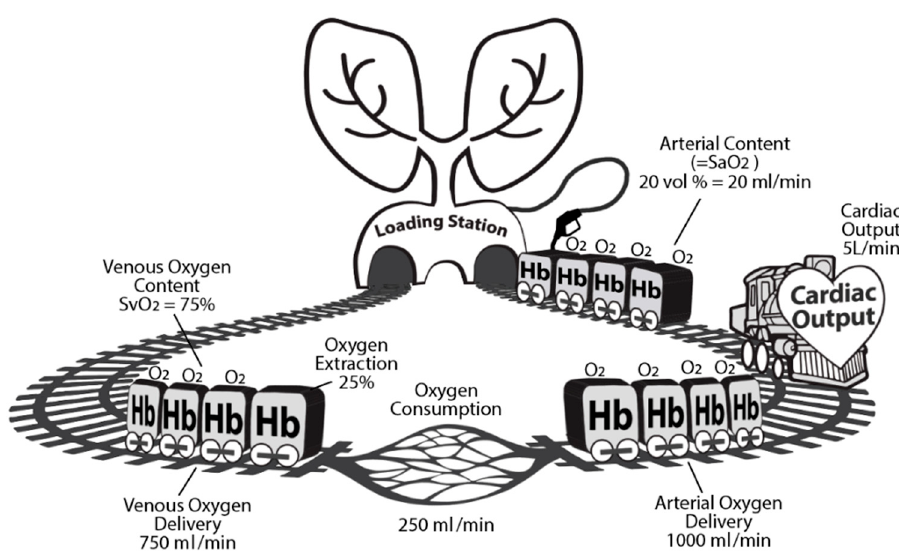
Figure 4. The Oxygen Choo-Choo Train illustrating the relationship between cardiac output, oxygen content, and oxygen consumption.